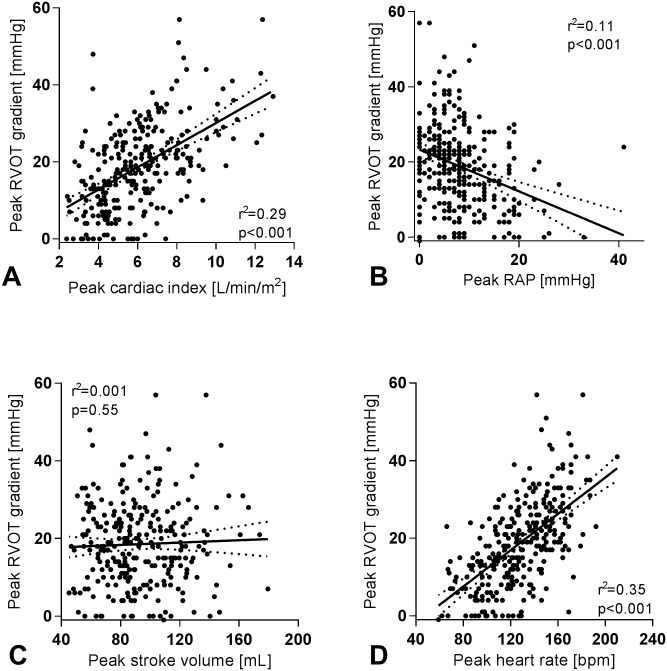
Association between selected exercise hemodynamic variables and right ventricular outflow tract (RVOT) systolic pressure gradient at peak exercise.Scatterplots showing the relationship of various peak exercise hemodynamic variables with RVOT systolic pressure gradient at peak exercise. The best-fit linear regression line is plotted with 95% confidence intervals. Panel A—Peak cardiac index versus peak RVOT gradient; Panel B—Peak RAP versus peak RVOT gradient; Panel C—Peak stroke volume versus peak RVOT gradient; Panel D—Peak heart rate versus peak RVOT gradient. RAP—right atrial pressure; RVOT—right ventricular outflow tract.